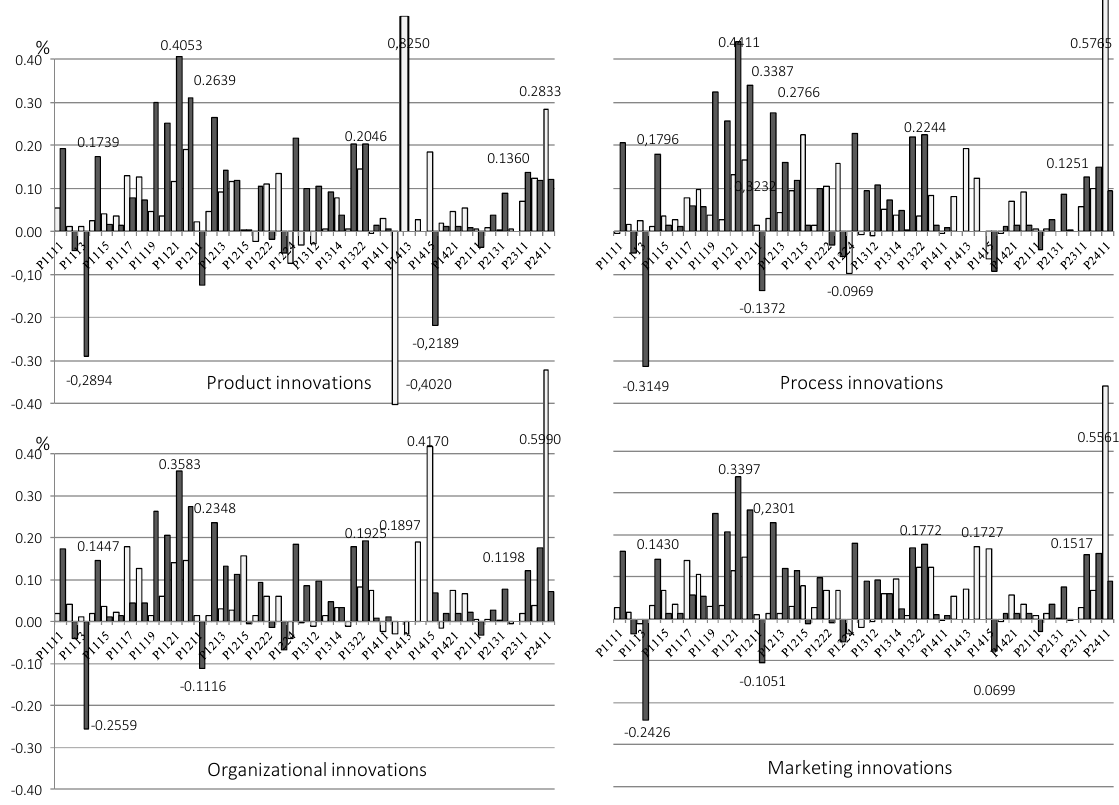
Figure 2. Graphic interpretation of mutual